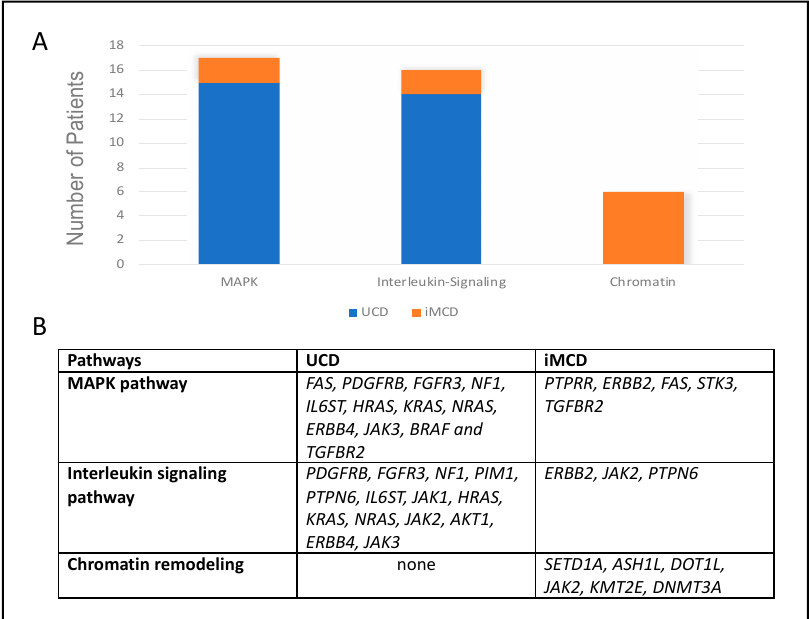
Figure 4. ( A ). Bar graph displaying the number of cases with gene mutations involved in the three main pathways enriched in Castleman disease (CD). ( B ). Table of the genes mutated in unicentric Castleman disease (UCD) and idiopathic multicentric Castleman disease (iMCD) that are part of the three main pathways.